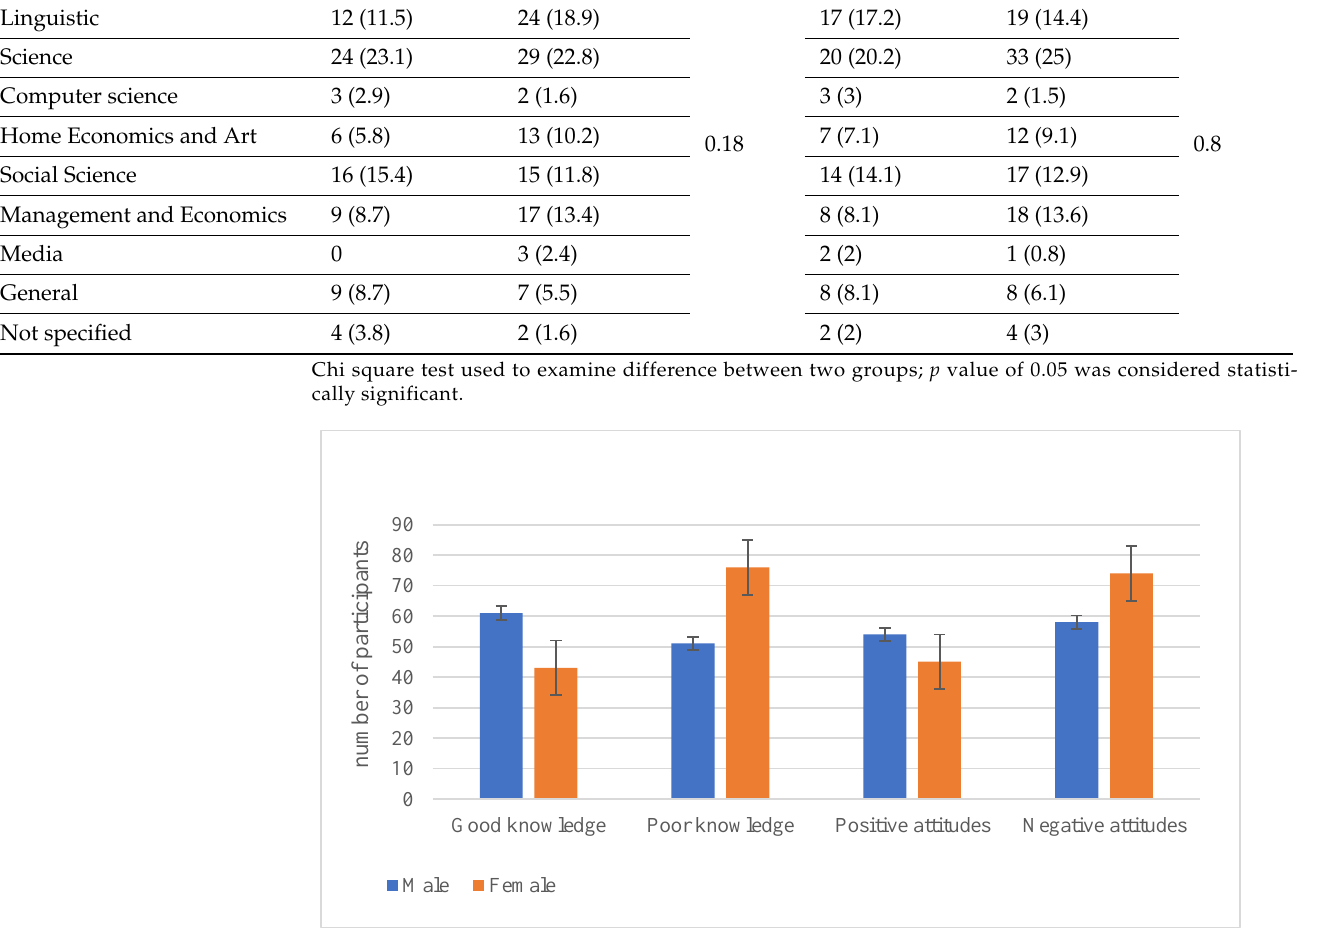
Figure 1. Gender differences in knowledge and attitudes toward vitamin D among health educators in public schools. Table 5. Association between knowledge, and attitude scores toward vitamin D and selected socio- demographics for health educators stratified by gender.